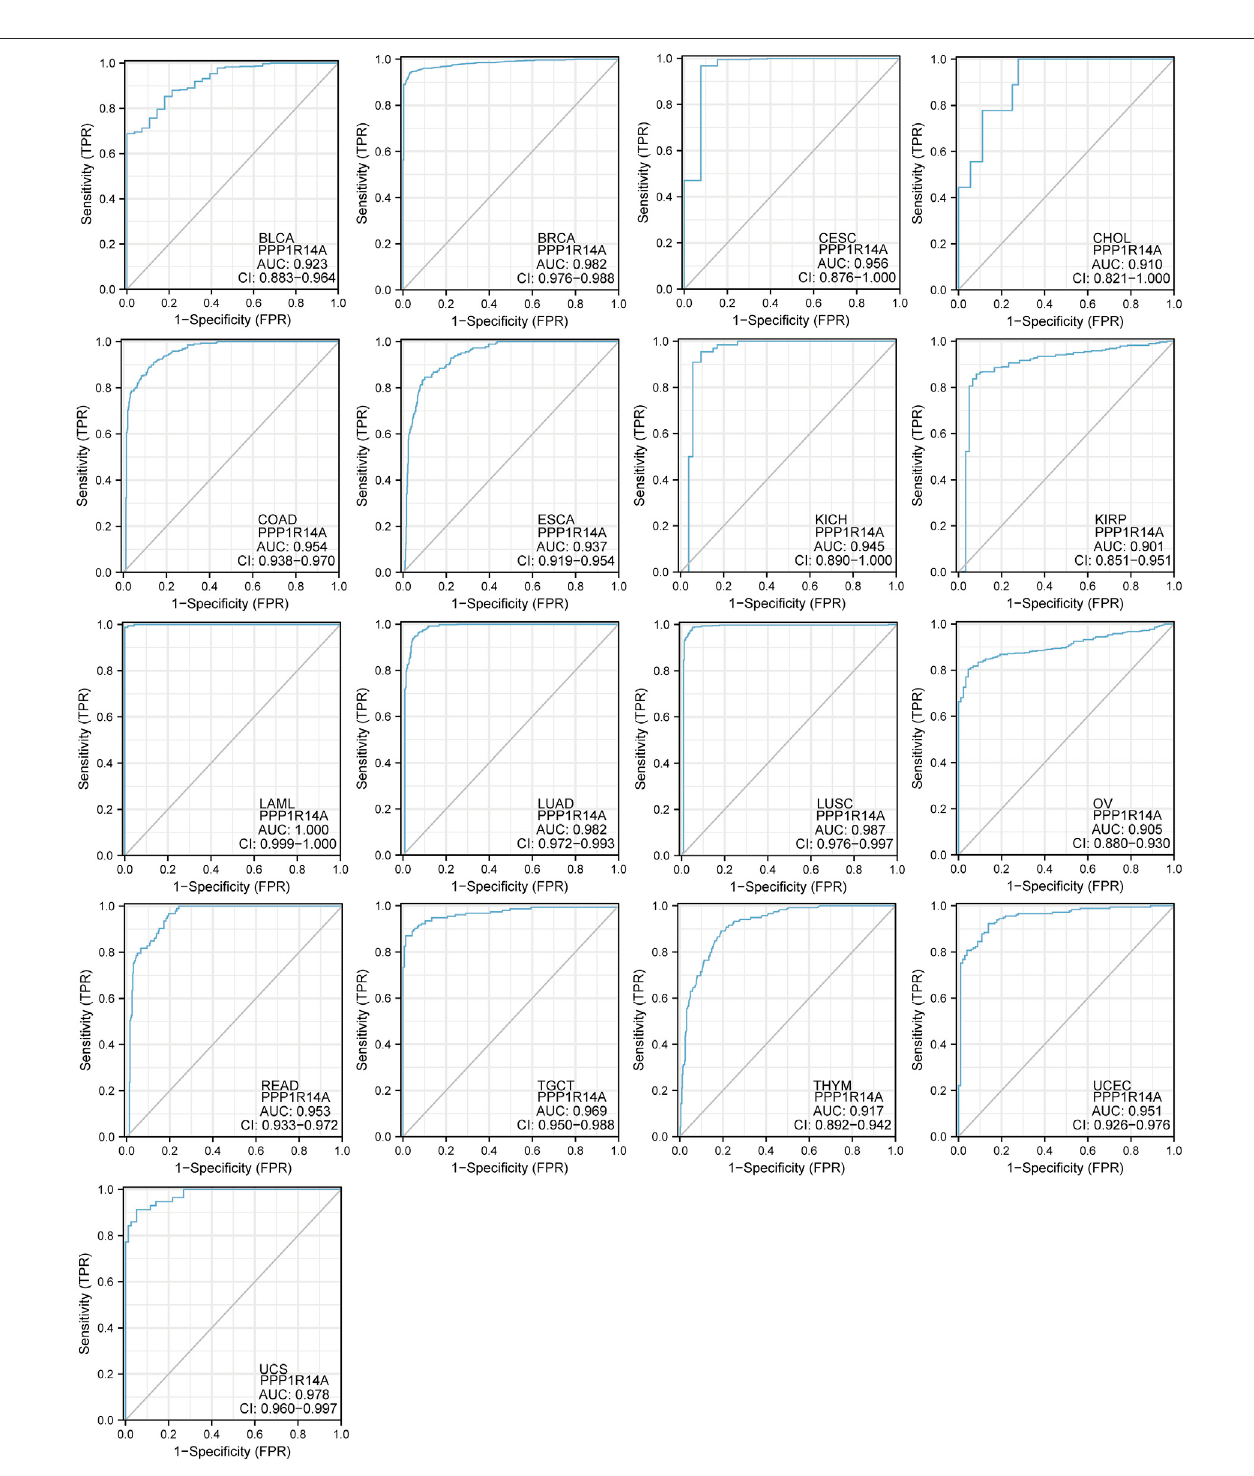
FIGURE 7 | Receiver operating characteristic (ROC) curves for PPP1R14A across BLCA, BRCA, CESC, CHOL, COAD, ESCA, KICH, KIRP, LAML, LUAD, LUSC, OV, READ, TGCT, THYM, UCEC, and UCS.